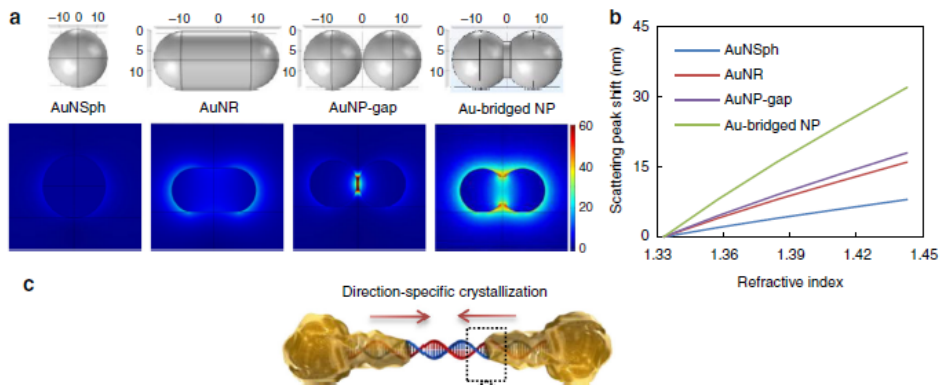
Figure 10. Synthesis-by-design of plasmonic nanoparticles (NPs) in solution. ( a ) Illustrations of the designed NP models (upper; dimensional unit, nm) and plasmon resonance electric field patterns (below; unit, Vm − 1 ) generated by numerical simulations. ( b ) Linear fits to localized surface plasmon resonance (LSPR) wavelength shifts vs. changes in the refractive index (RI) of the NP surroundings. ( c ) Schematic diagram showing the early stage of direction-specific, contour-following, and shape-controlled crystallization of Au atoms by reducing AuCl4 − with NH3OH + .The water interface of DNA provides precise controllability under the synthetic conditions at pH 5 and 4, generating NPs with nanobridges and nanogaps respectively. Adapted with permission from Ma et al. [58] Copyright © 2019 Nature.